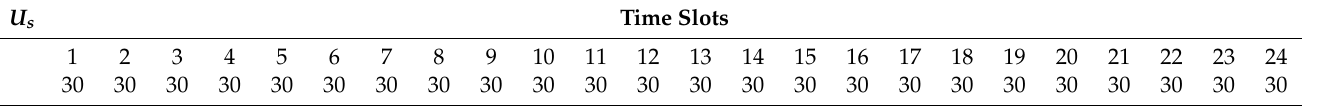
Table 5. The number of available trucks during each time slot.